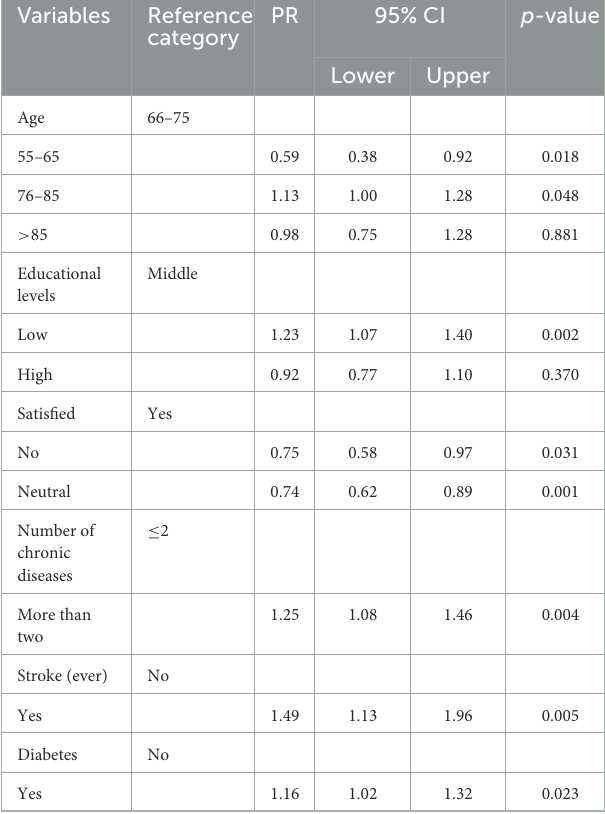
TABLE 4 Results of log-binomial models examing factors associated with participation in the EHCP among the elderly.